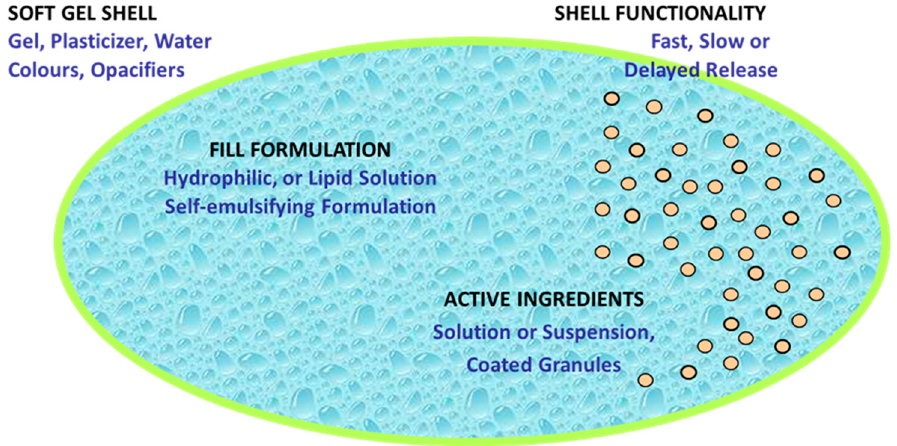
Figure 4. Schematic representation of the soft gel functional dosage form.